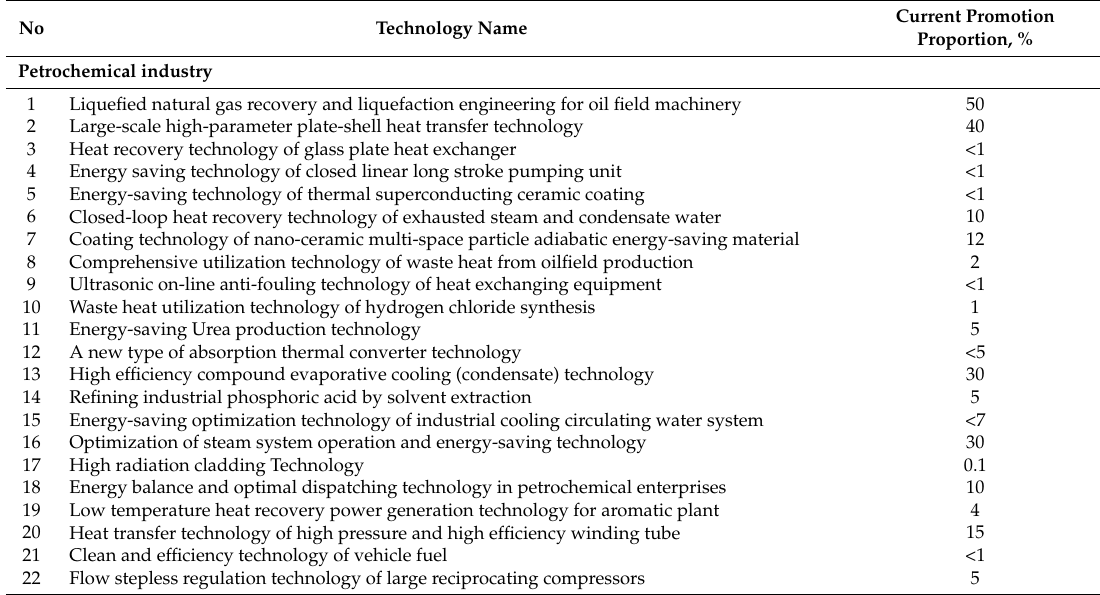
Table A1. Technology name and promotion